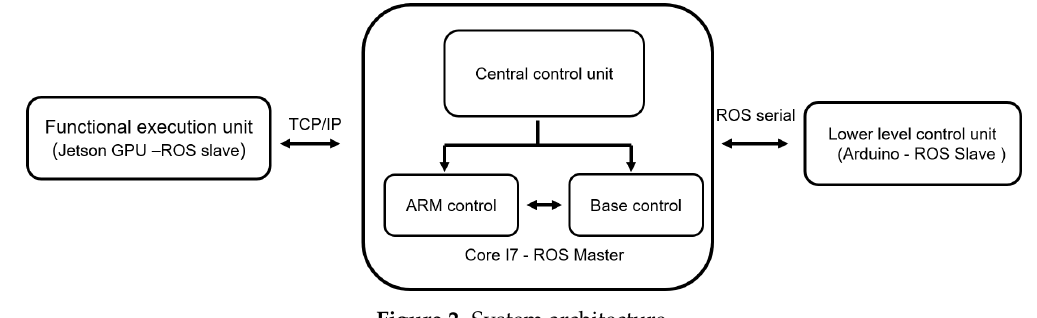
Figure 2. System